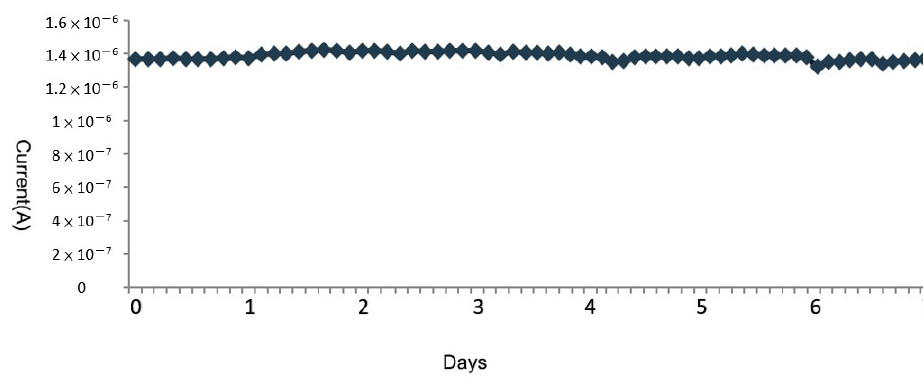
Figure 14. Long-term current change during 7 days.